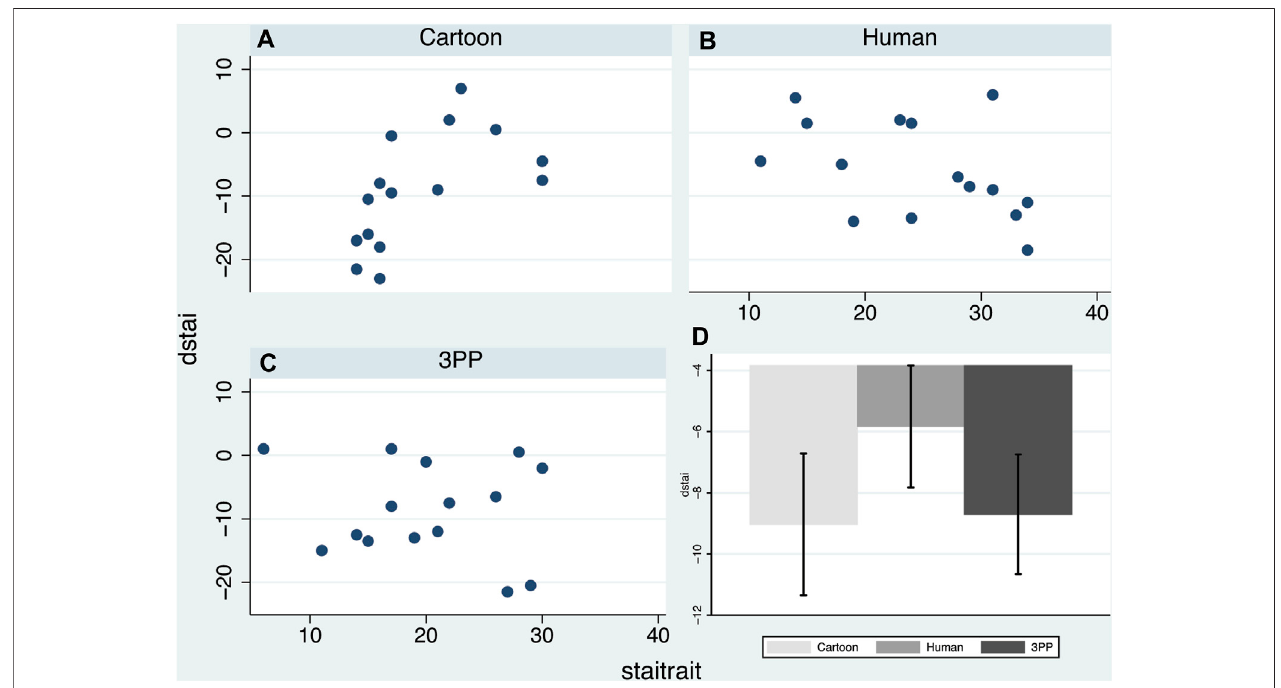
FIGURE 3 | Plots of dstai ( Eq. 1 ) — the difference between the anxiety score after exposure 3 compared to the mean anxiety score prior to exposures 1 and 2 by staitrait. (A – C) — scatter diagrams by condition. (D) Bar chart of dstai showing the means and standard errors by condition.